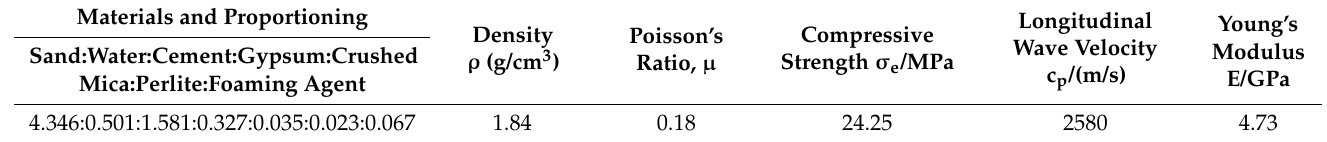
Table 4. Materials, proportions, and basic physical and mechanical parameters of the simulated coal.